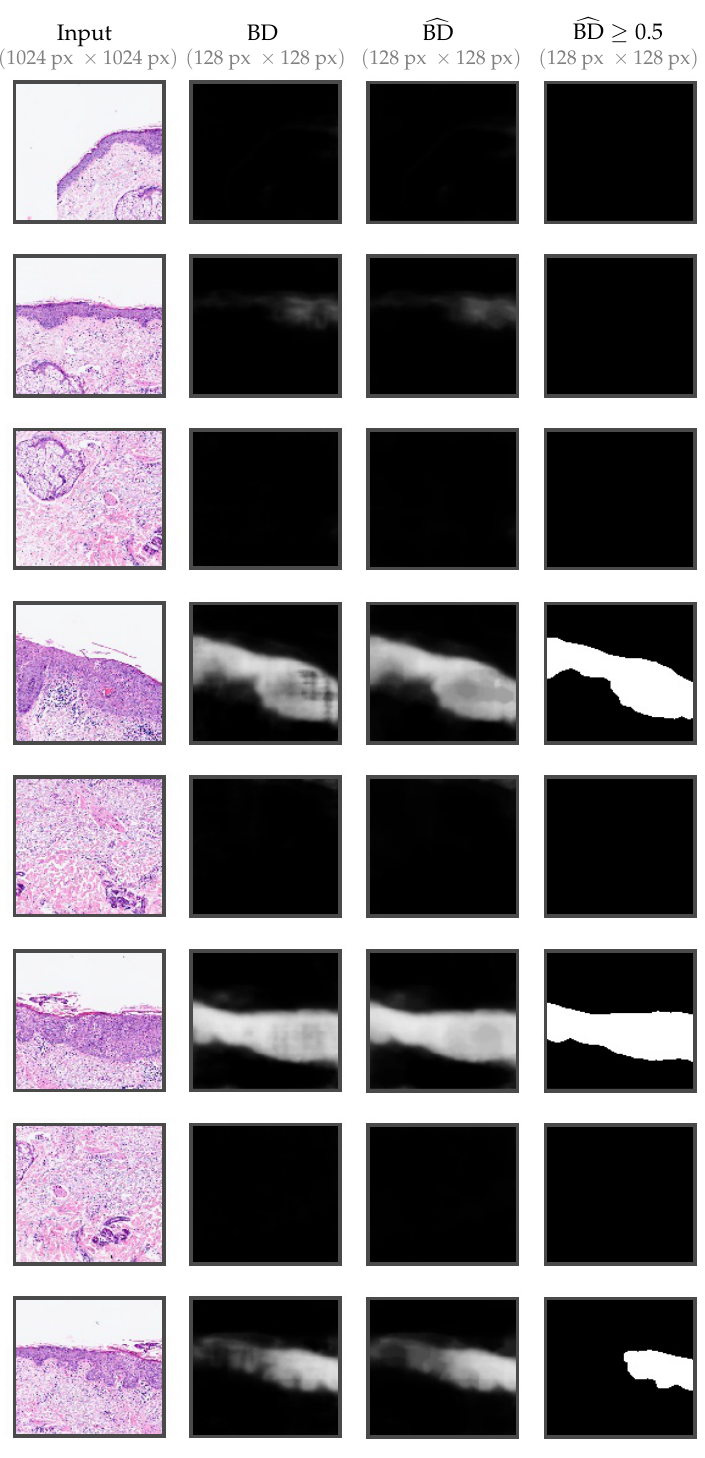
Figure 9. Output examples for some of the tiles (1024µm × 1024µm) from Figure 2. From left to right: original tile, the output of the network (only BD), post-processing, the binary result after applying a threshold of